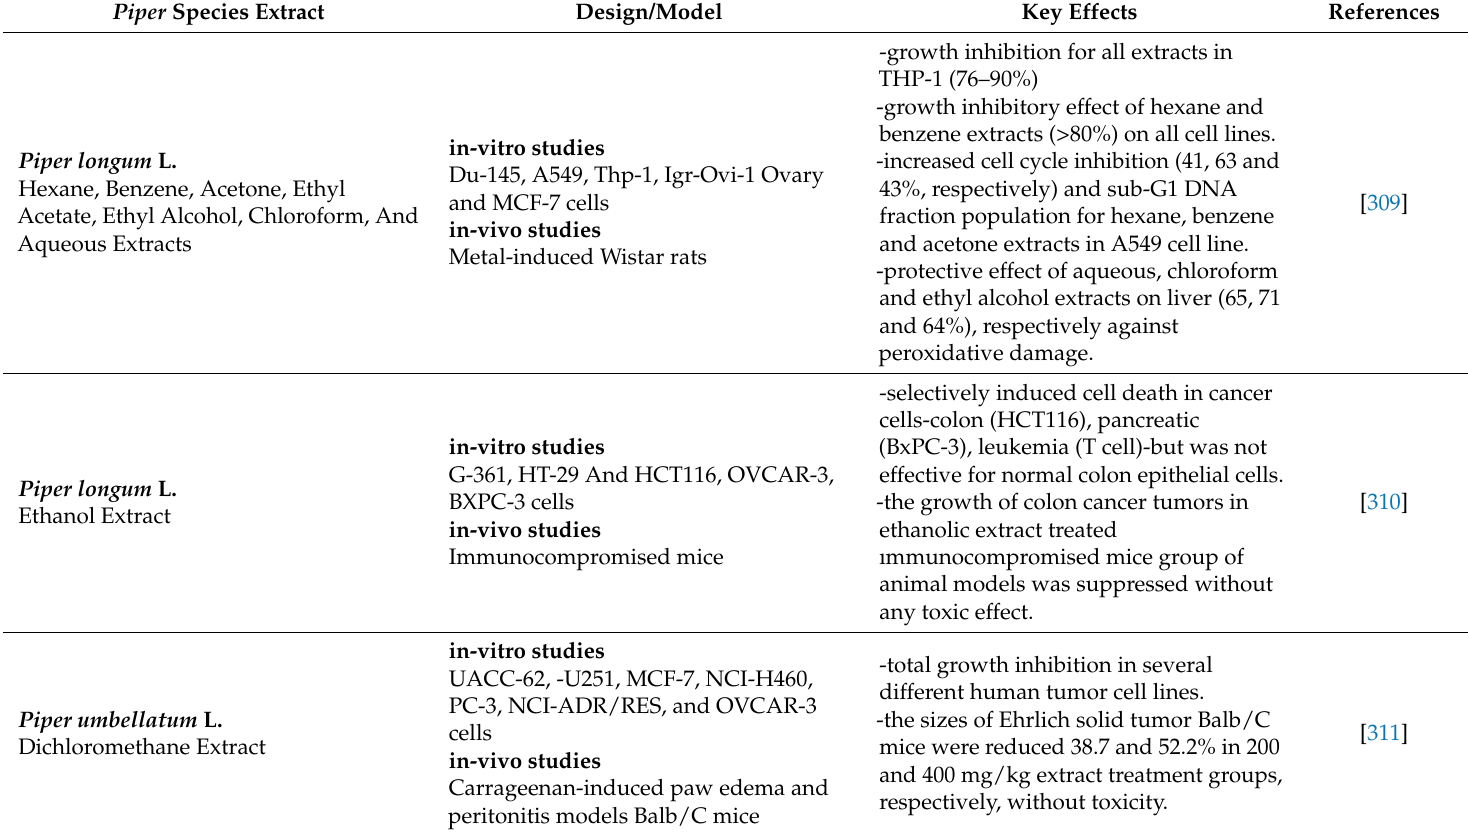
Table 30. Antiproliferative properties of different Piper